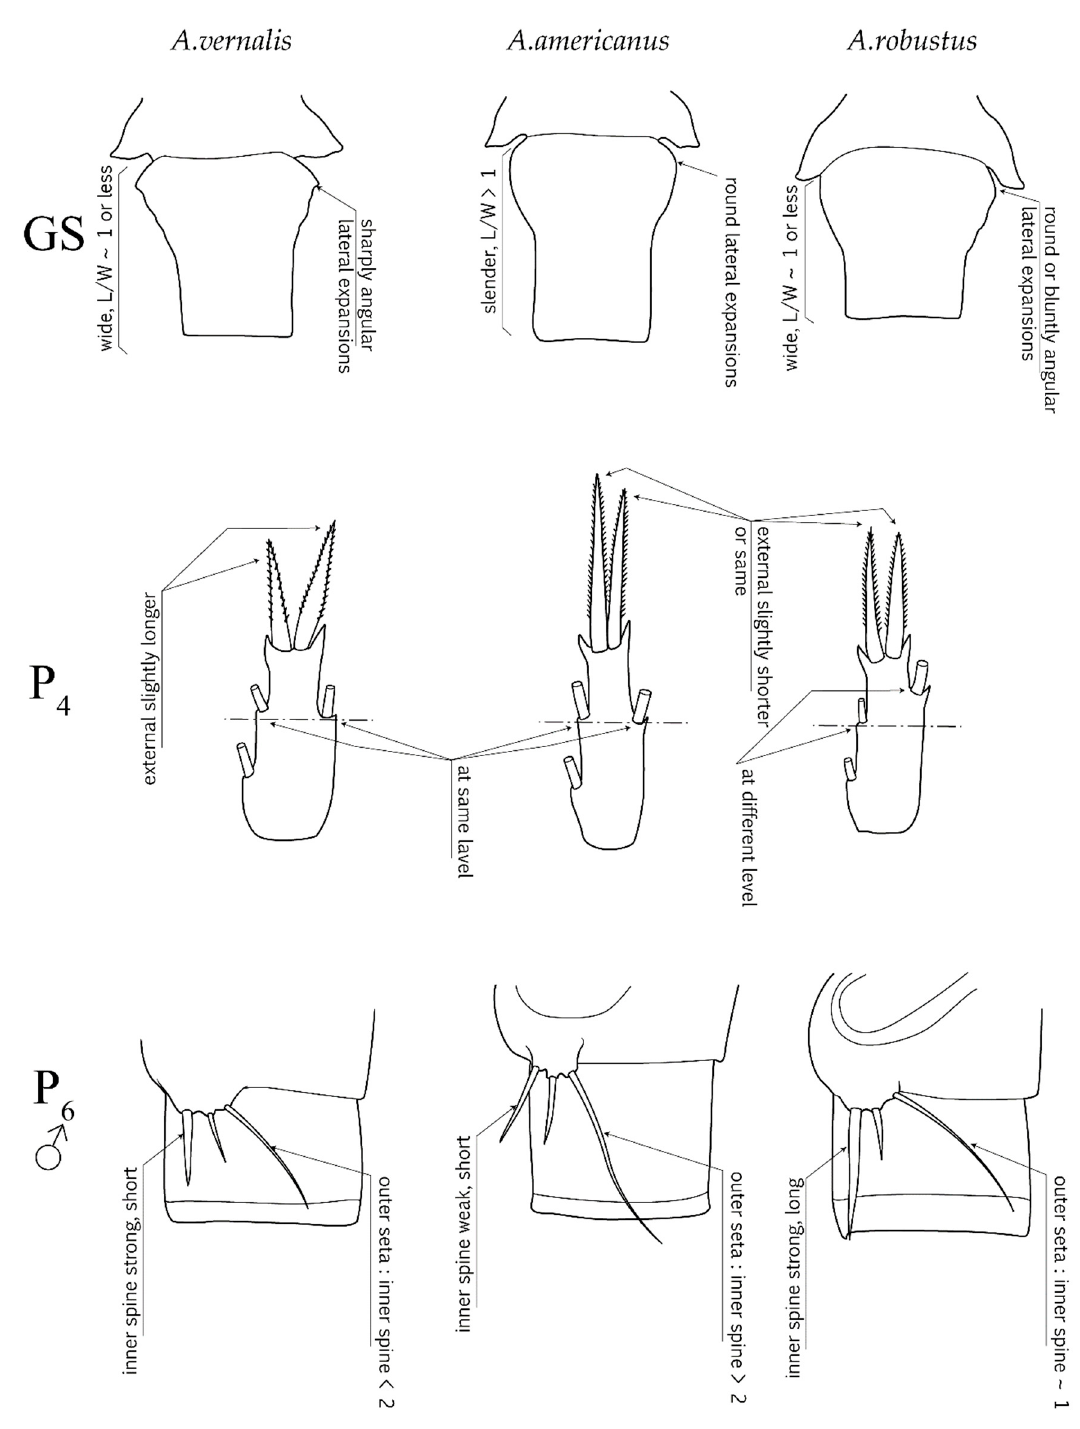
Figure 2. Scheme of the main differences between adults of Acanthocyclops vernalis , Acanthocyclops americanus and Acanthocyclops robustus .